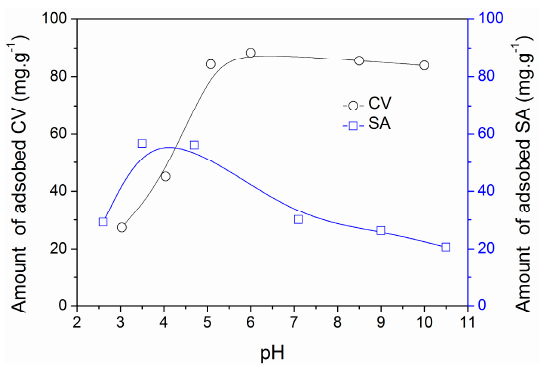
Figure 9. Effect of pH on adsorption of CV (25.1 mg·L − 1 ) and SA (50.2 mg·L − 1 ).